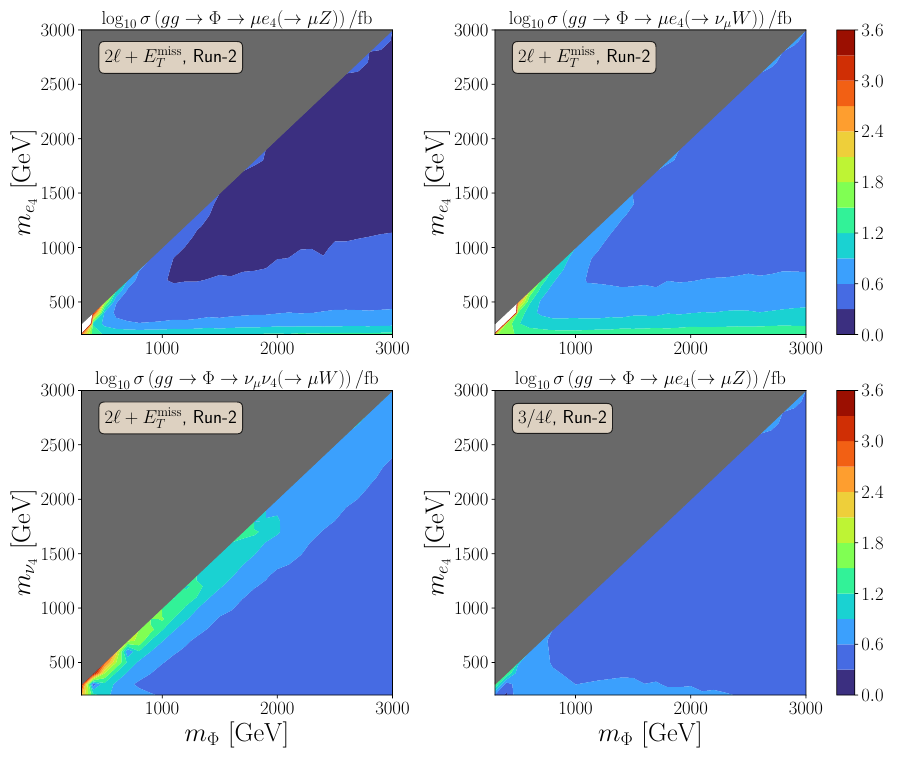
Figure 3 . Current upper bounds on σ ( gg → Φ → ‘‘ 4 ( → ‘ 0 V )) from our recast of the 2 ‘ + E miss and 3 / 4 ‘ searches. See the texts for the